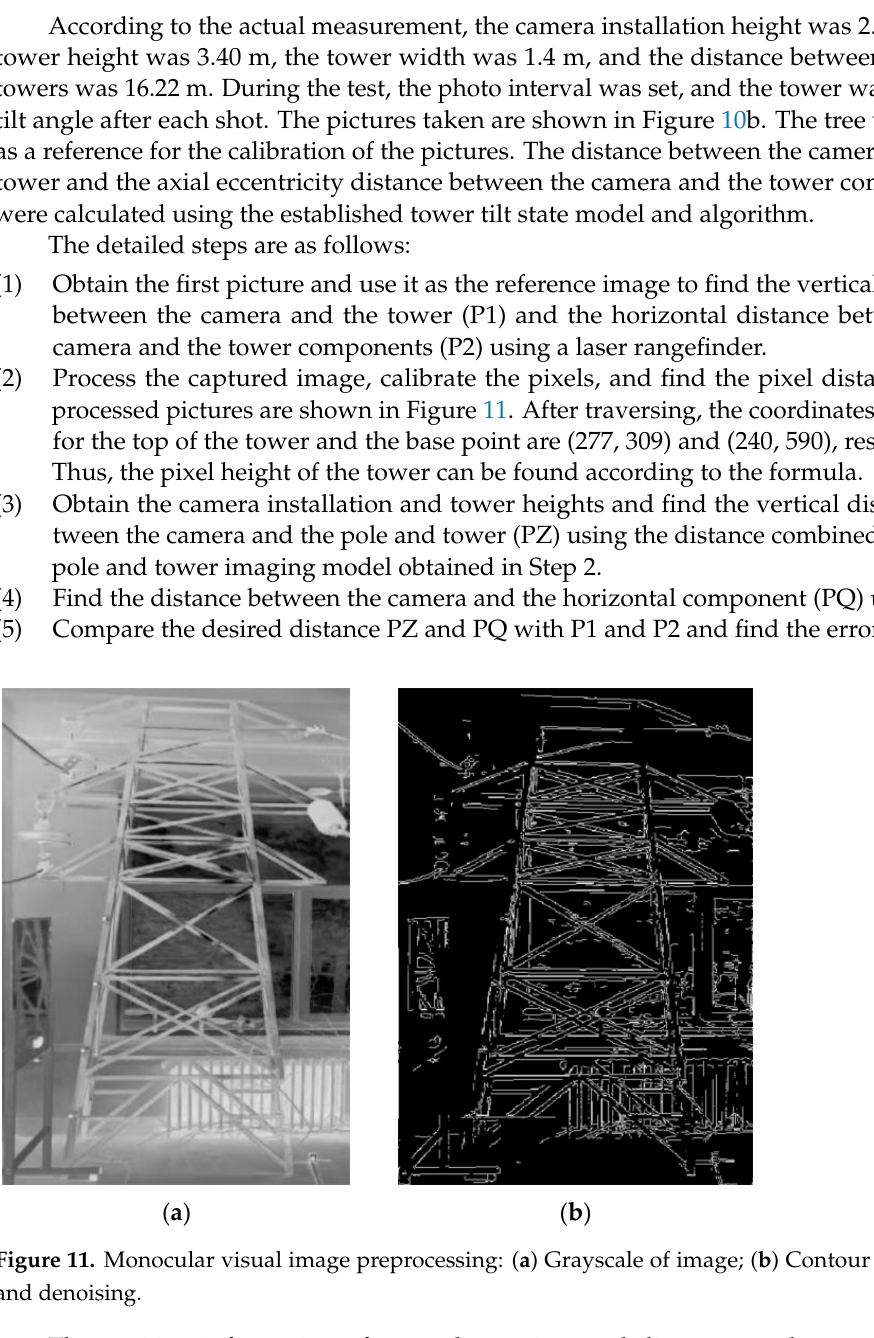
Figure 10. Experimental environment construction: ( a ) Indoor monocular vision camera setting; ( b ) The picture was taken by monitoring terminal.